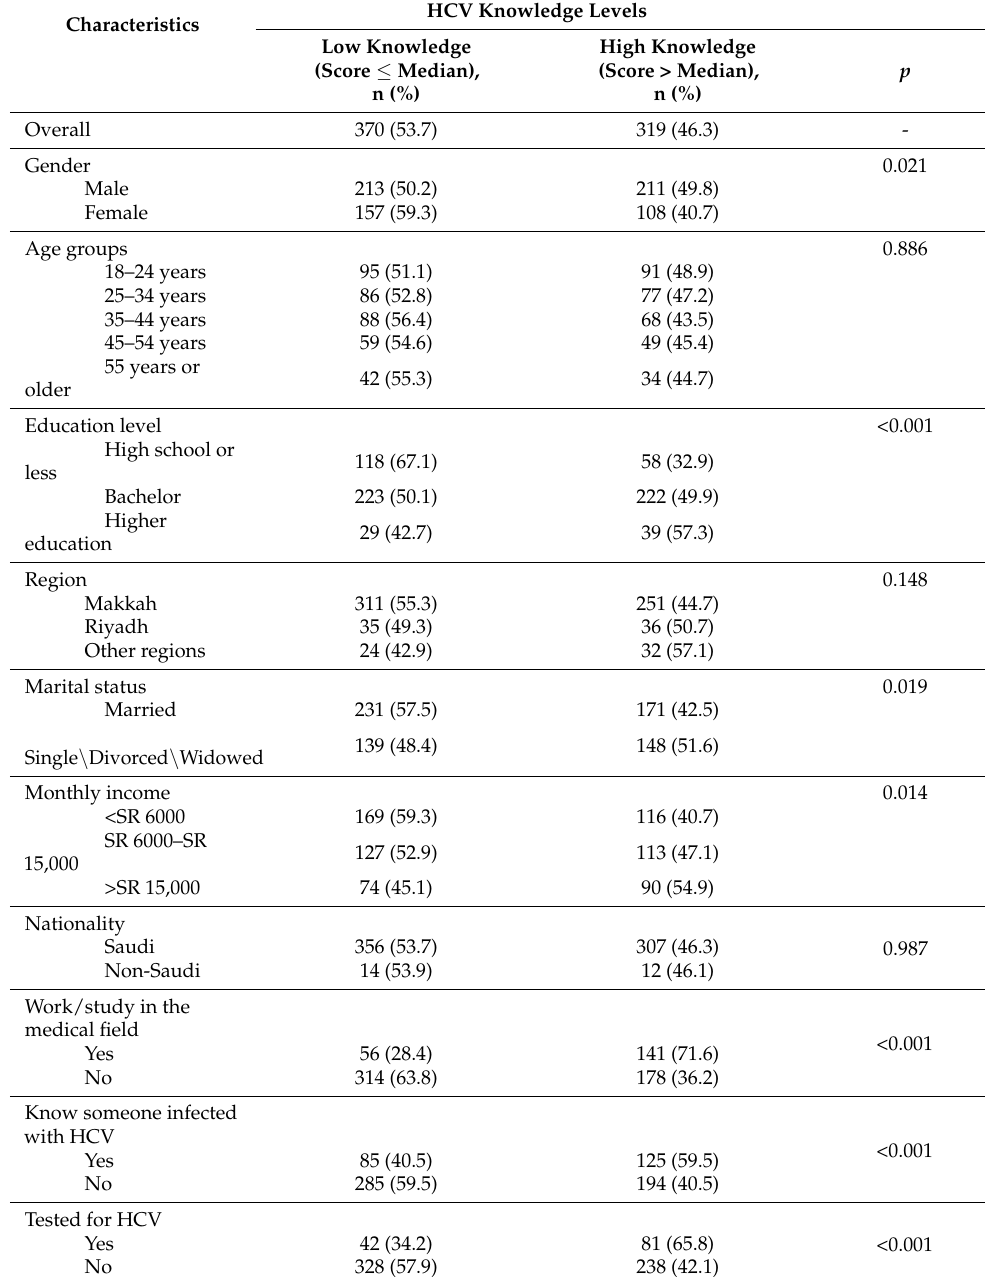
Table 3. HCV knowledge levels by the characteristics of the study